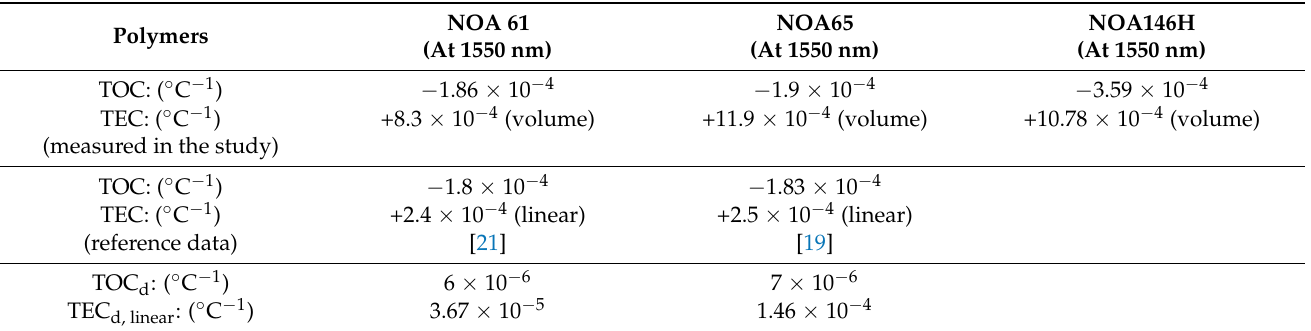
Table 1. Comparisons of the simultaneously measured TEC and TOC for three types of polymers between the experimental results and the reference